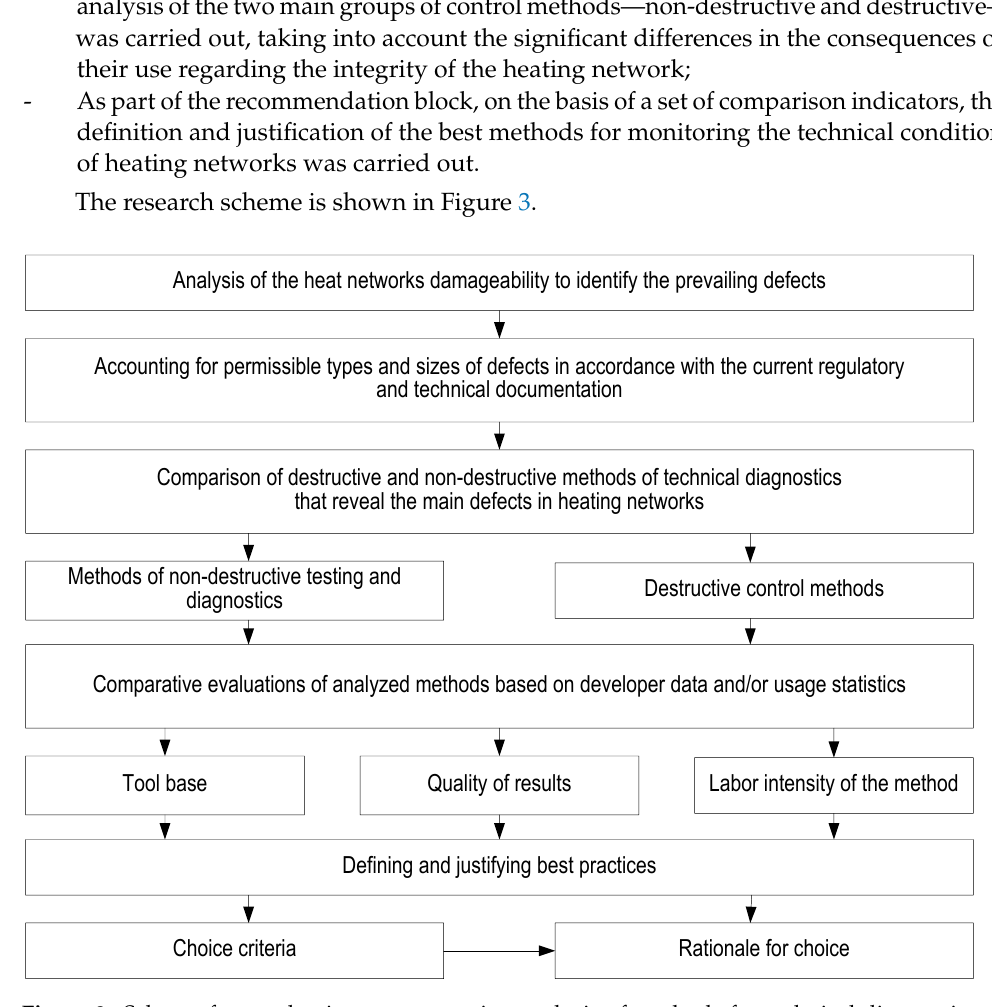
Figure 3. Scheme for conducting a comparative analysis of methods for technical diagnostics of heat networks.